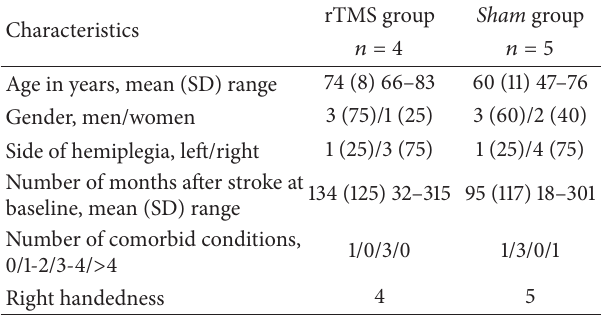
Table 1: Baseline characteristics of study subjects who completed the